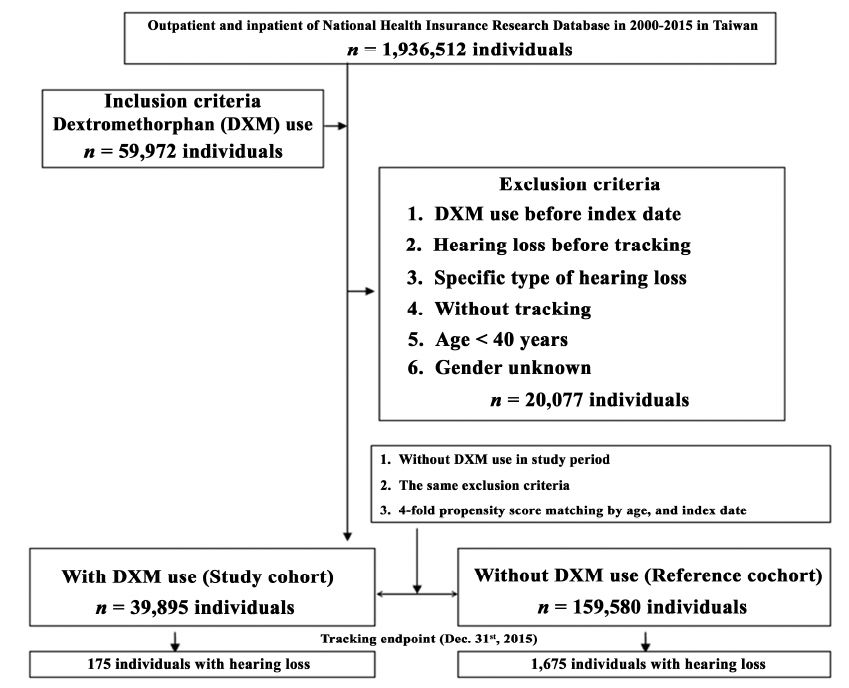
Figure 4. Flowchart of study sample selection.